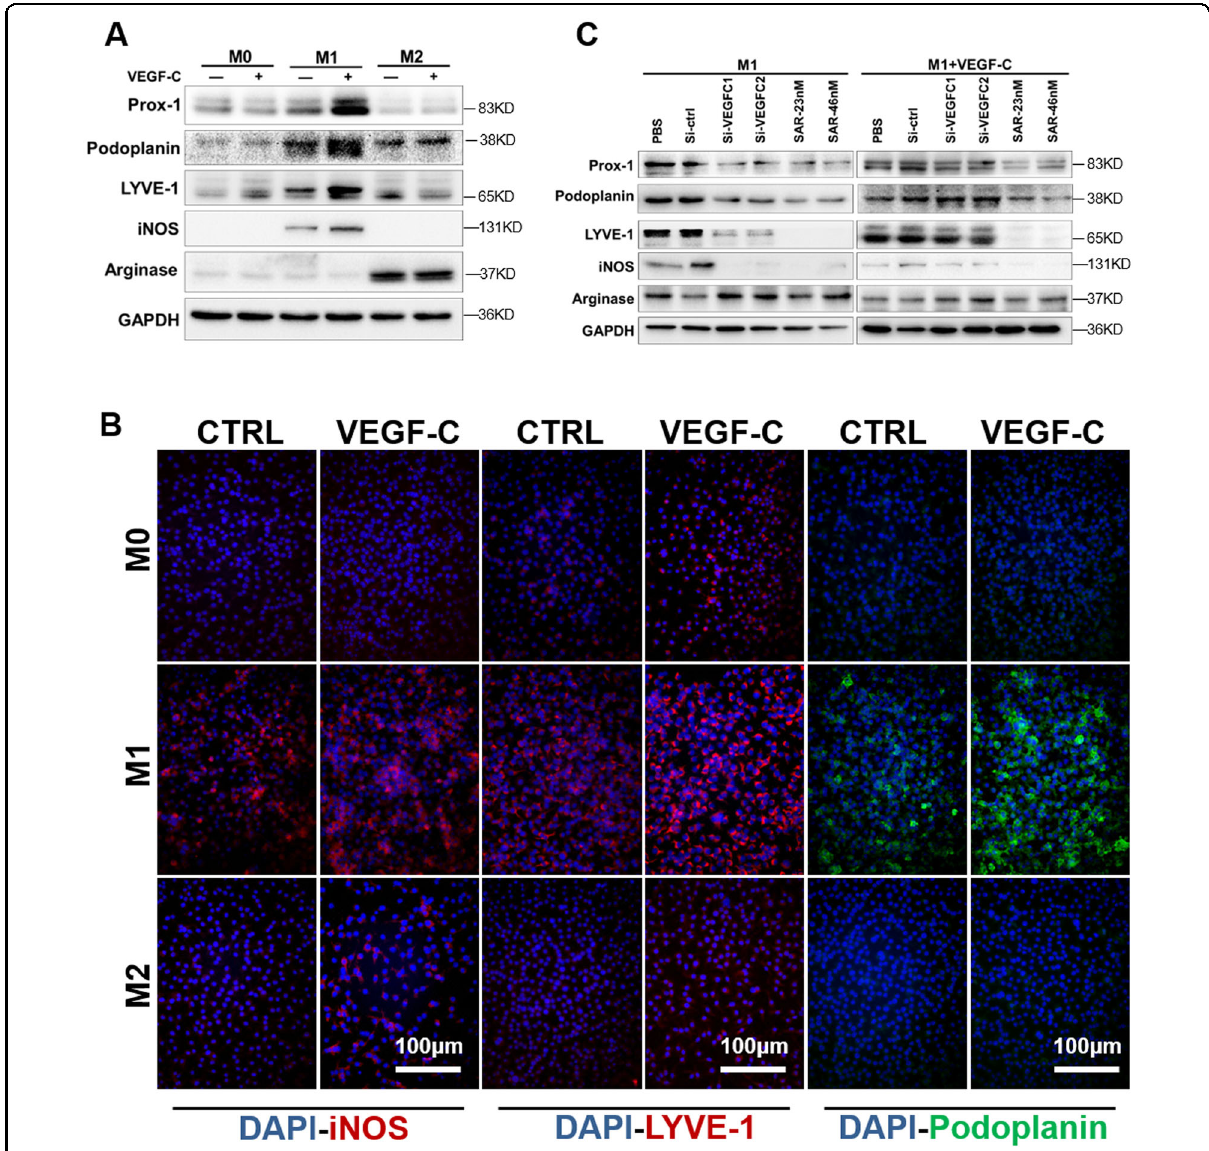
Fig. 4 VEGF-C stimulated M1 further polarization and transdifferentiation into lymphatic vessel cells. A Primary BMDMs subtypes were stimulated by VEGF-C in vitro, and then the expression of macrophage activation markers (iNOS for M1, arginase for M2) and lymphatic vessel markers (Prox-1, LYVE-1, and podoplanin) were measured by western blotting. B In vitro, primary BMDMs were analyzed by immuno fl uorescence for iNOS, LYVE-1, and podoplanin expression after VEGF-C stimulation or control treatment (CTRL) (400×). C M1 macrophages were treated with VEGF-C, siRNA for VEGF-C (Si-VEGF-C), and the VEGFR3 inhibitor SAR131675 (SAR-23/46nM), and then the protein expression of iNOS, arginase, and lymphatic vessel markers (LYVE-1 and Prox-1) was